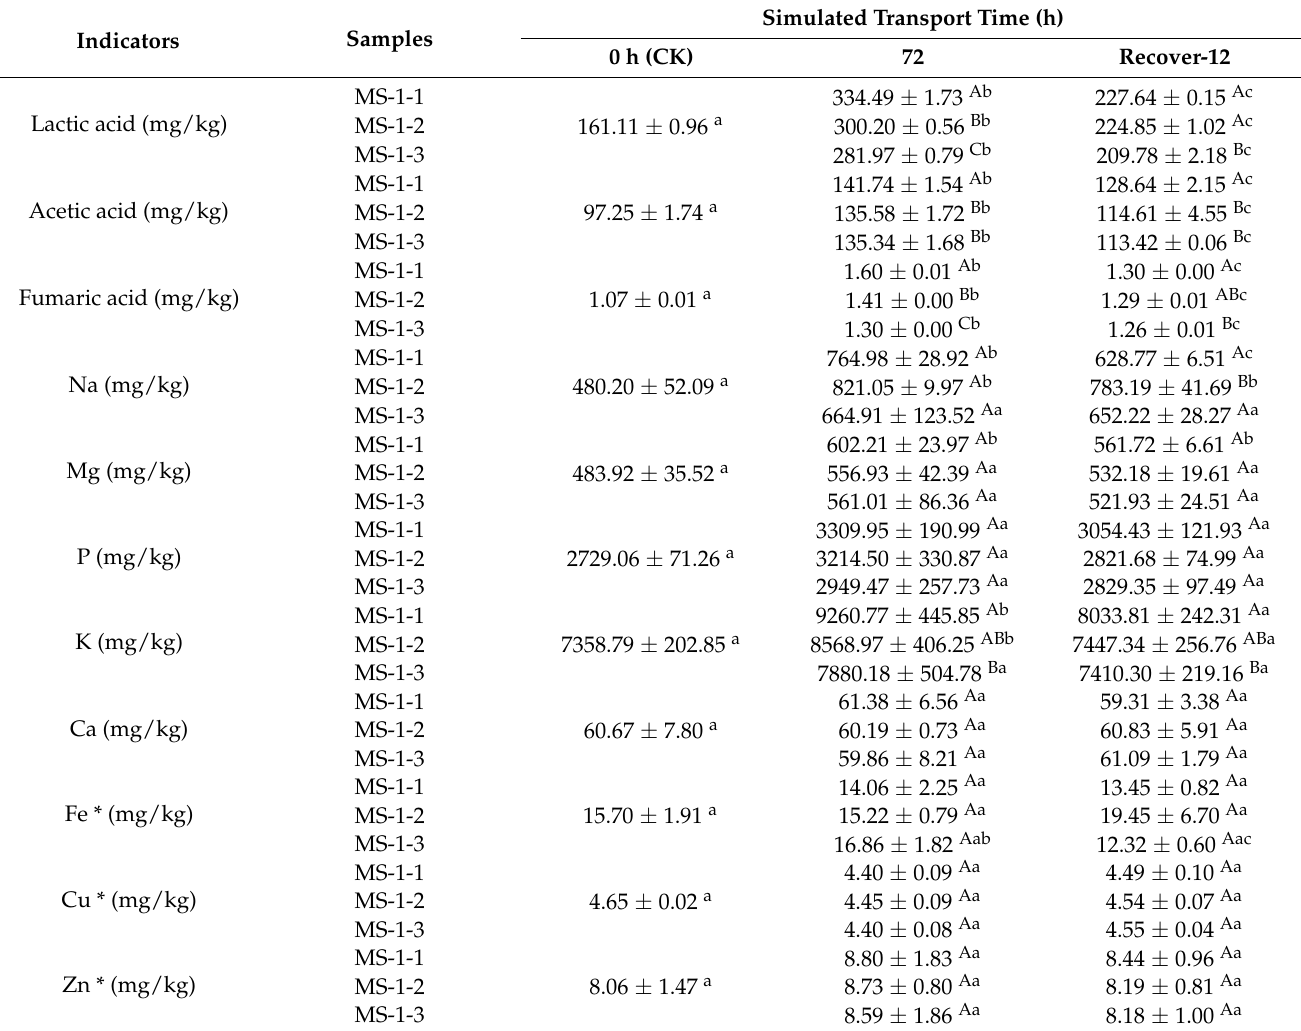
Table 5. The changes in organic acid and minerals of the sea bass before and after simulated live